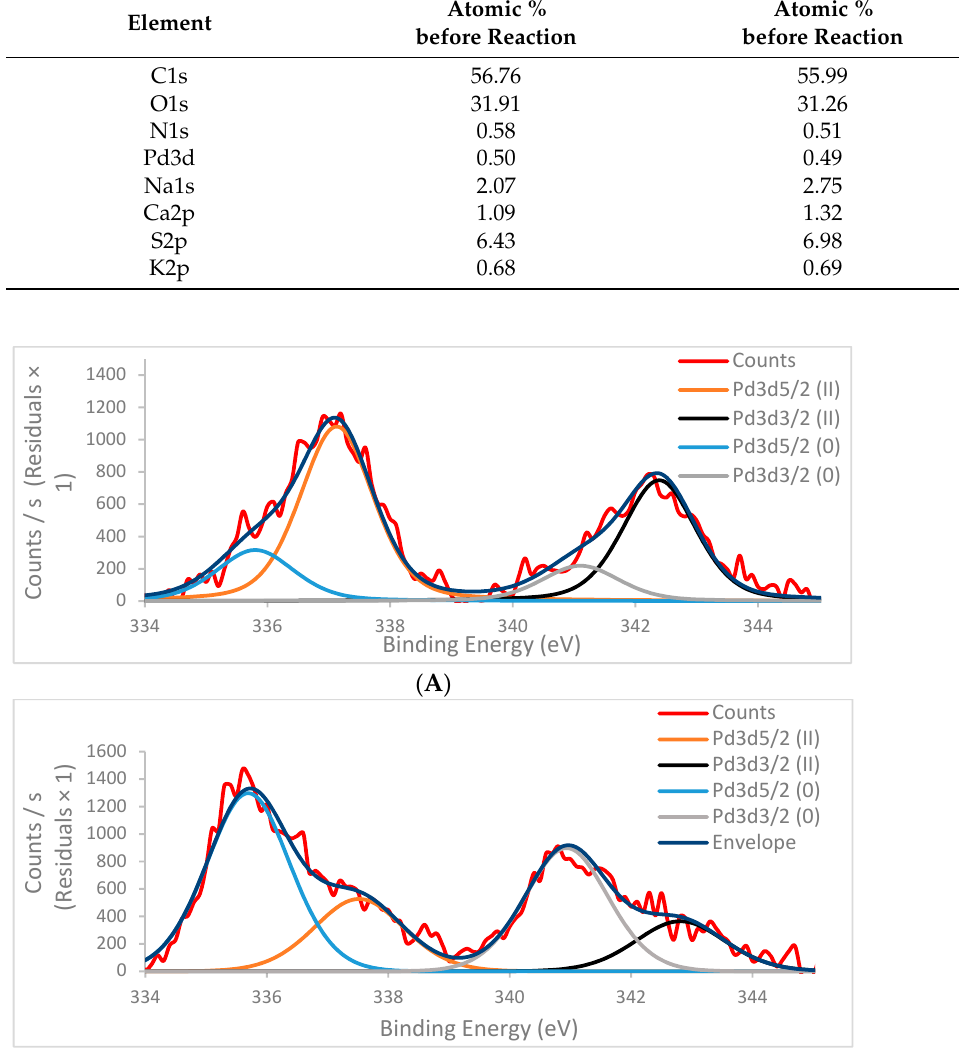
Table 3. Elemental identification and quantification of i -Pd(OAc) 2 (TPPTS) 2 before and after reaction, determined by XPS.